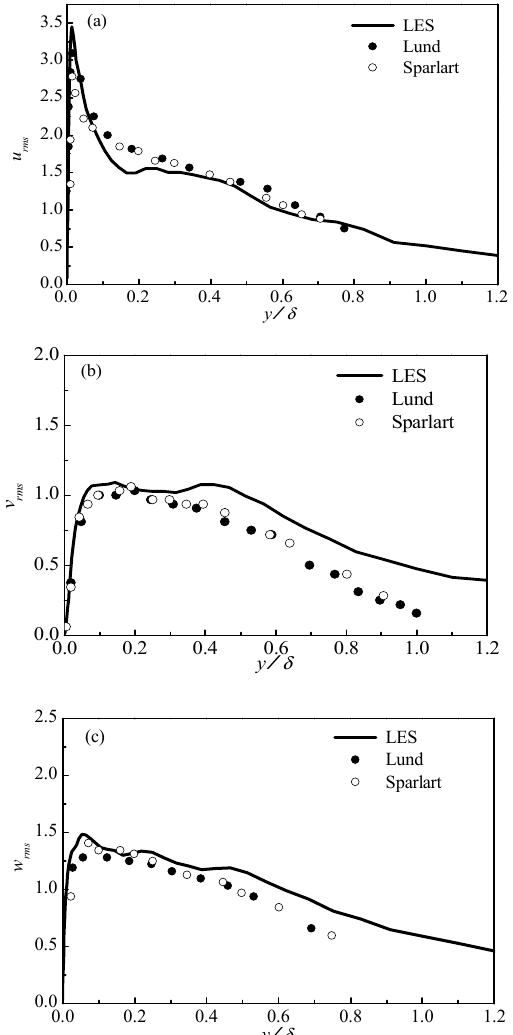
Figure 4. Comparison of LES and Direct Numerical Simulation (DNS) [43,44] for fluctuation intensity distribution ( a ) streamwise, ( b ) normal, and ( c ) spanwise. The data shown are extracted from the area below 20 mm downstream from the obstacle line.